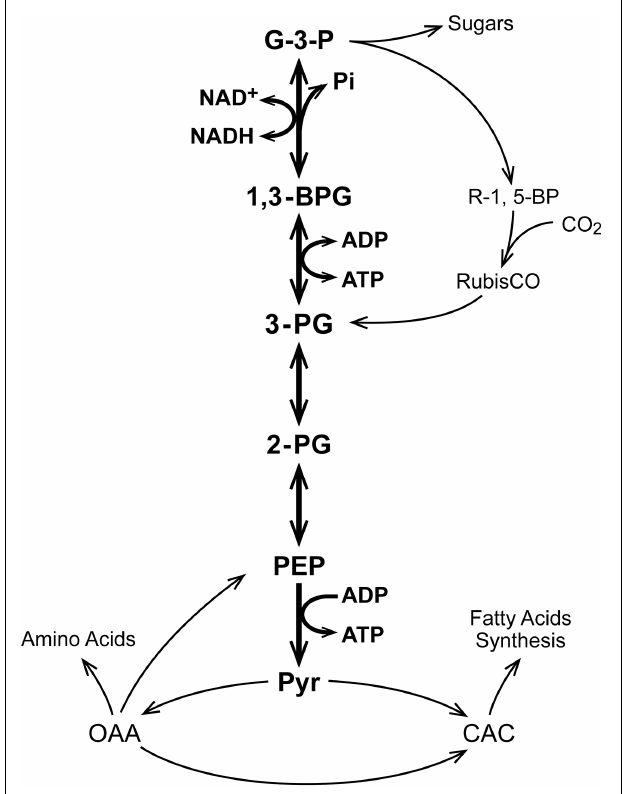
In green plants, the Calvin Cycle occurs within the chloroplast and uses NADPH as the reductant but this is a “recent” evolutionary development (1–2 Gya). These core reactions are coupled to all other metabolism in autotropes, in which all of the organic molecules in the organism are derived from G-3-P. Only a few of the coupled metabolic pathways are